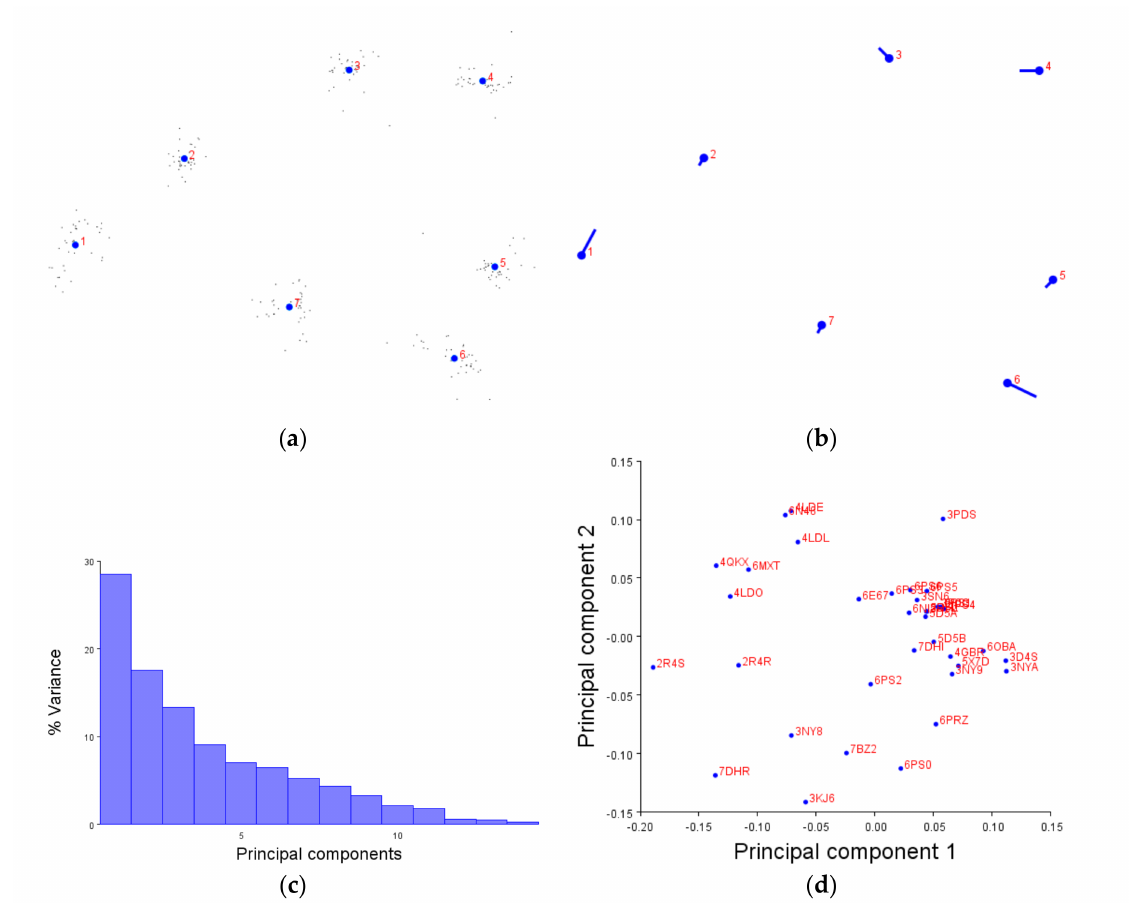
Figure 2. The four graphs generated by geometric morphometrics and principal component analysis using extracellular β 2AR data as an example. ( a ) Generalised Procrustese transformation standardises the dataset to show an average position (blue numbered dots) and the individual data (black dots) around them. In this case, this can be thought of as a top-down view of the extracellular TM bundle. ( b ) Lollipop graph visualising morphospace variation caused by principle component 1 (PC1). The average position of each helix is represented by the blue dot; the stick protruding away from the dot shows the direction and magnitude of variation caused by PC1 (the greatest source of variation). ( c ) Principal component eigenvalues and the percentage of variance they account for—PC1 always gives the most variance, and then PC2 second, and so on. ( d ) Comparison between PC1 and PC2; this is used to assess the greatest variation of the dataset’s morphospace and to observe patterns produced by the data. Each dot represents a GPCR structure within the selected dataset and can be labelled with PDB codes or different colours. A list of structures included in each figure can be found in the Appendix A tables, and further supplementary figures in Appendix